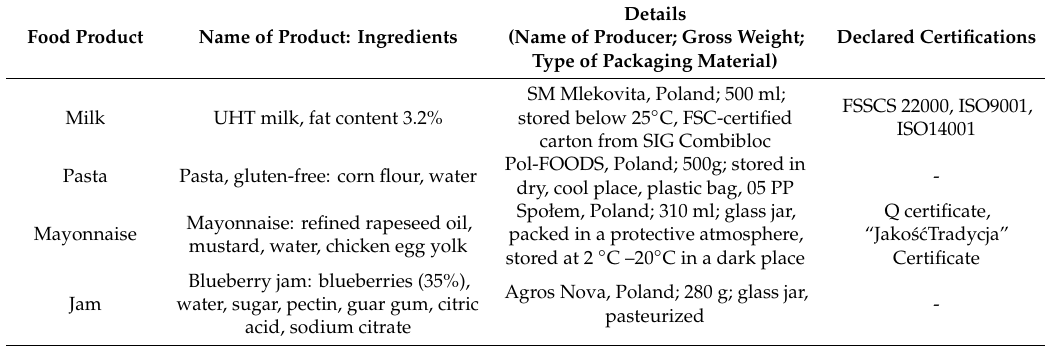
Table 2. Details of foodstu ff